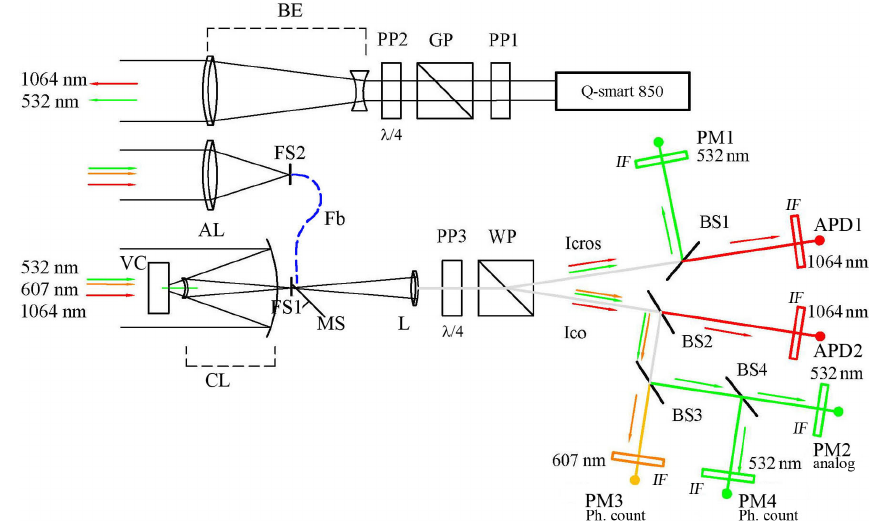
Figure 2. Optical circuit of the LOSA-M3 lidar. PP: phase plate. GP: Glan prism. BE: achromatic beam expander. AL: achromatic lens with 40mm diameter. CL: Cassegrain mirror lens with 200mm diameter. VC: video camera. FS1 and FS2: iris diaphragms. Fb: optic fiber. MS: mirror shutter. L: lens. WP: Wollaston prism. BS: beam splitter. APD: avalanche photodiode. PMT: photomultiplier